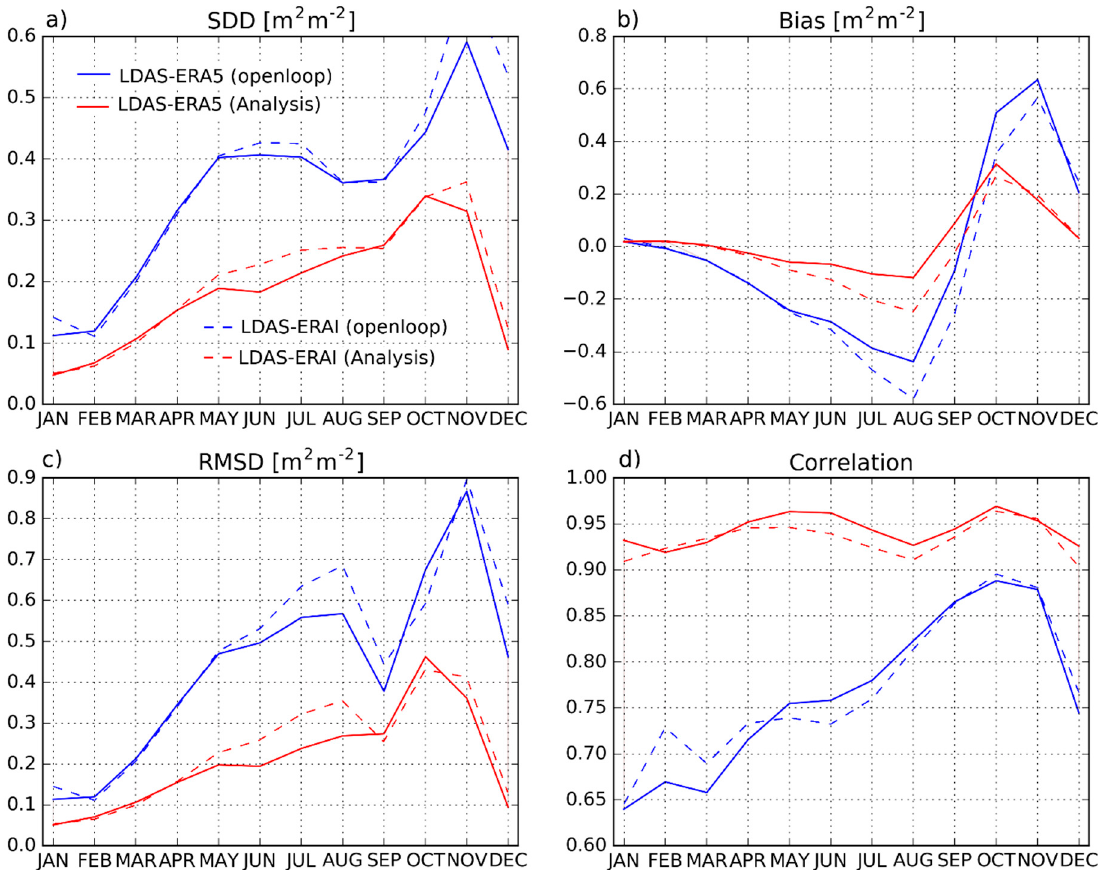
Figure 10. Seasonal (a) SDD (b) bias (c) RMSD and (d) correlation between LAI from either LDAS-ERA5 (solid lines) or LDAS-ERAI (dashed lines) model (blue) and analysis (red) and observed LAI over January 2001 to June 2018.